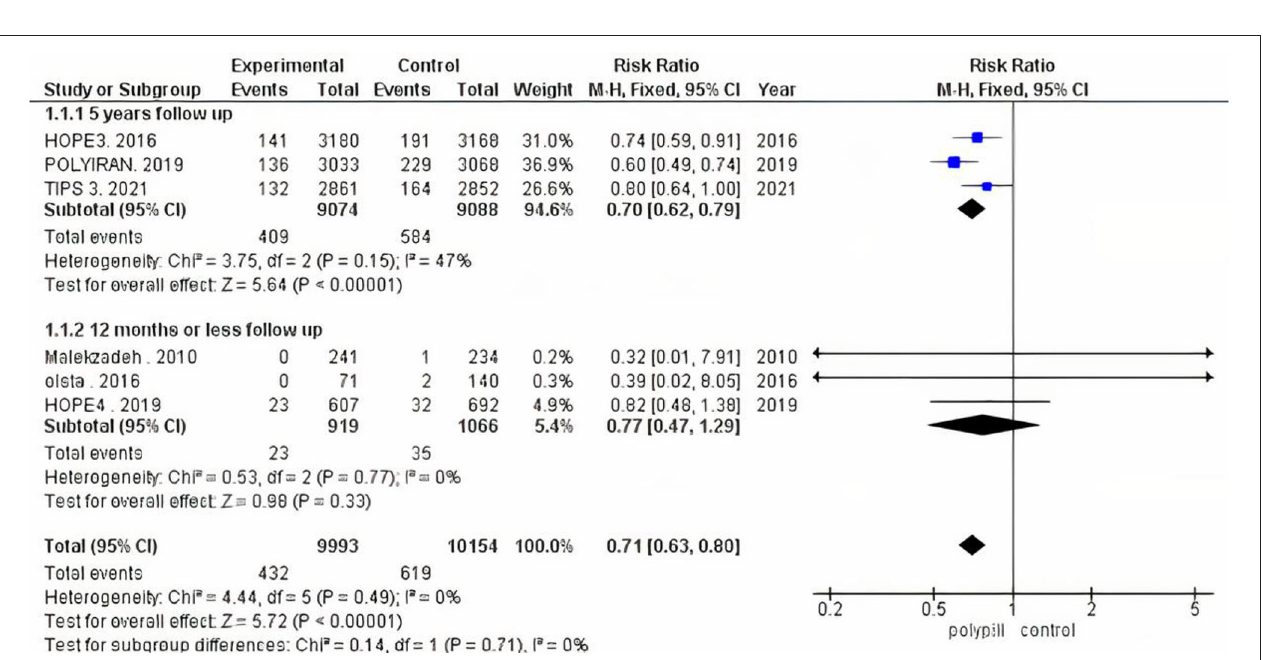
FIGURE 3 | Forest plot of total fatal and non-fatal CV events.